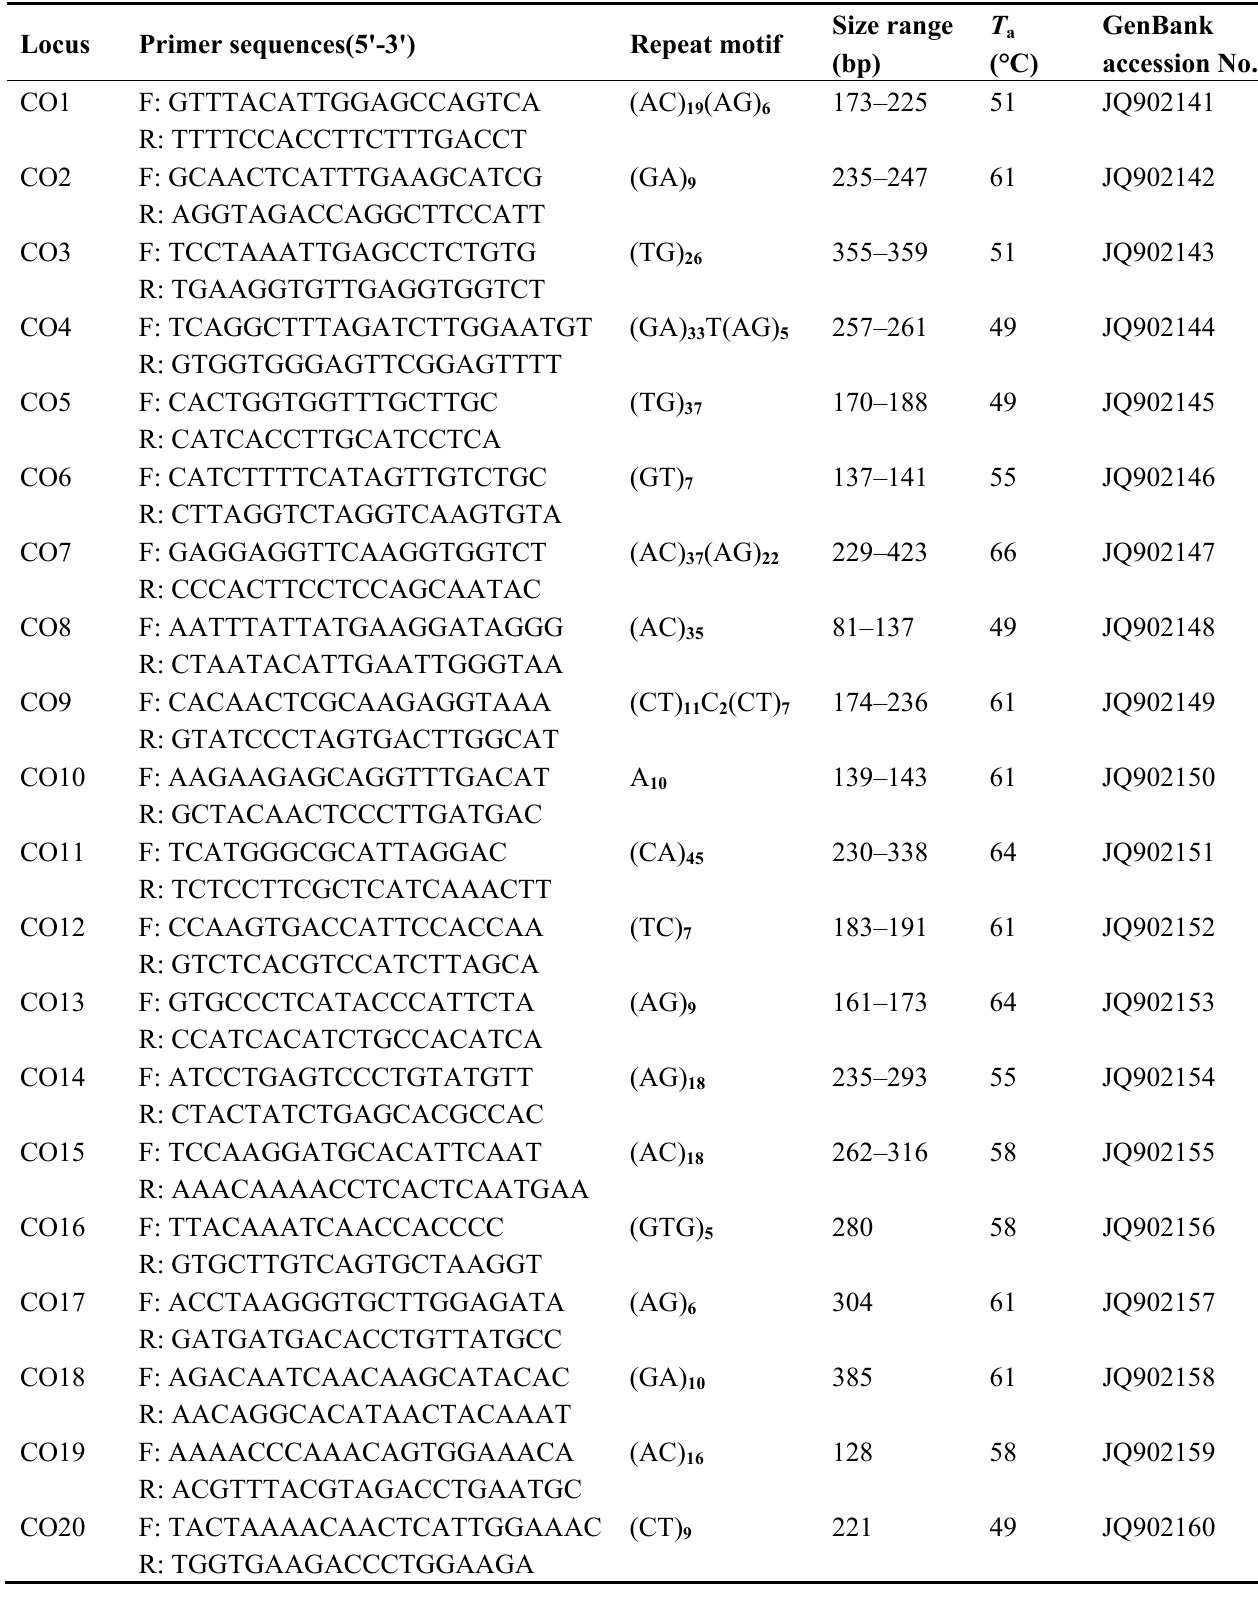
Table 1. Characteristics of 15 polymorphic and 12 monomorphic microsatellite loci for Cephalotaxus oliveri